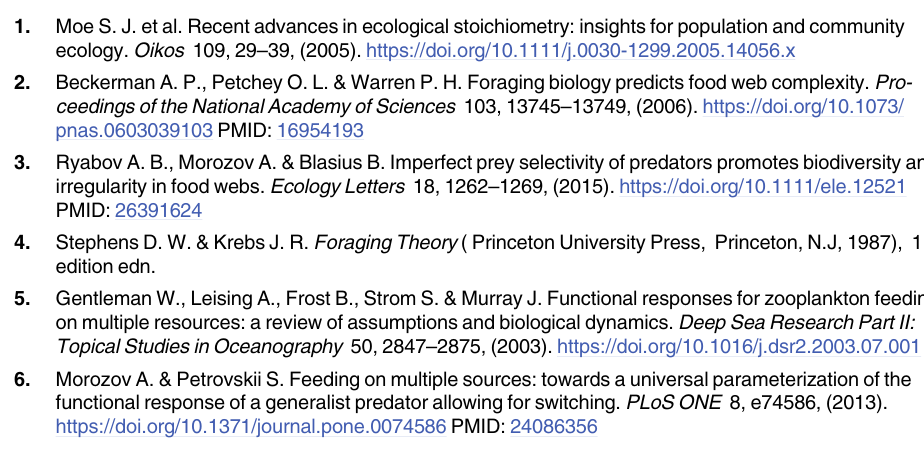
S1 Fig. Averaged prey selection in each treatment. Mean α ( ± 95% CI) of each prey type in each treatment (a-e) based on feeding without depletion. The prey abundance in a particular treatment is indicated in the label of each panel (altogether 8 snails were used in each treat- ment). In the case where the confidence interval overlaps with the dashed line (expected feed- ing under random prey selection) there is no selective feeding on a prey species. S1 Table. Absolute consumption of all prey species per treatment. Note that the number of replicates differs per treatment, the number of replicates per treatment can be found in Fig 2.